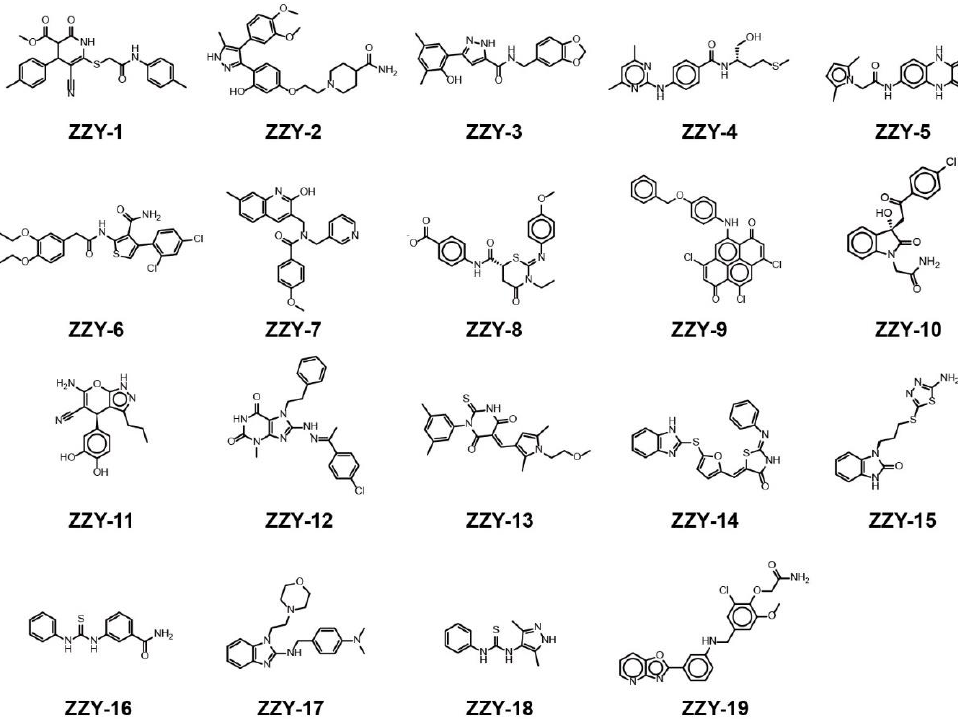
Figure 4. The chemical structures of ZZY-1 to ZZY-19.